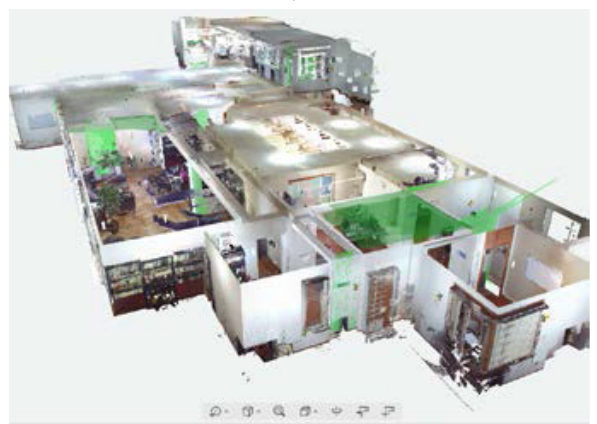
Figure 6: Interior point cloud.